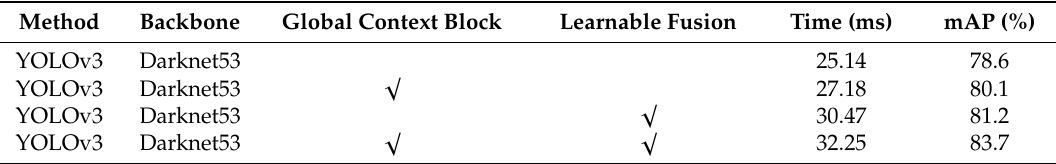
Table 4. Ablation study on the PASCAL VOC2007 test dataset.